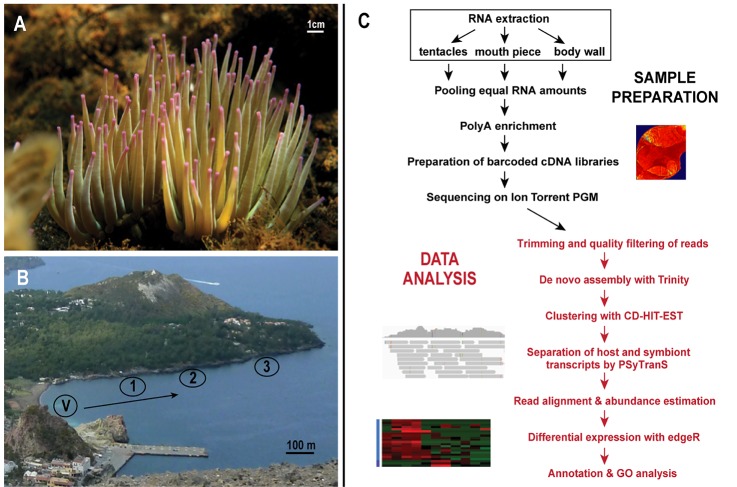
Sampling site overview and data analysis workflow.(A) The sea anemone Anemonia viridis growing at high CO2 (mean pH 7.6) at 1 m depth. (B) Sampling site location at Levante Bay (Vulcano Island, Italy); 1 – low seawater pH site with average pH 7.6; 2 – low seawater pH site with average pH 7.9 and 3 – reference site with average seawater pH 8.2. (C) General overview of laboratory methods and data analyses performed. V – vent site. (Photo credit: A - Demetris Kletou, B - Ilona Urbarova).